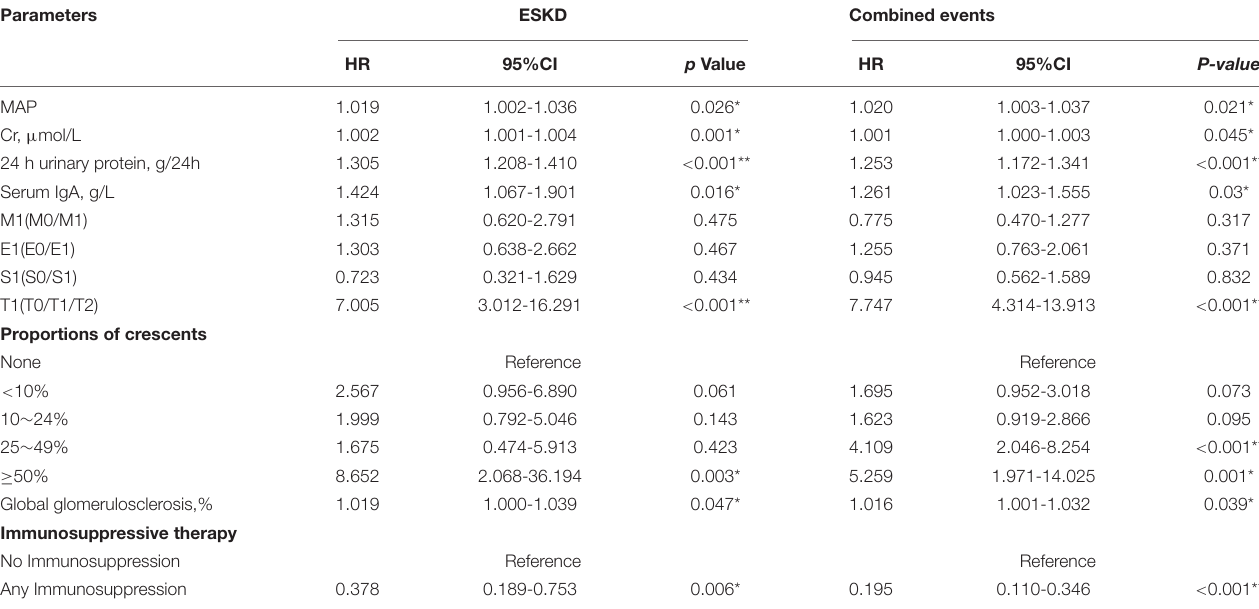
TABLE 4 | Multivariate analysis of clinical and pathological factors for the combined events.